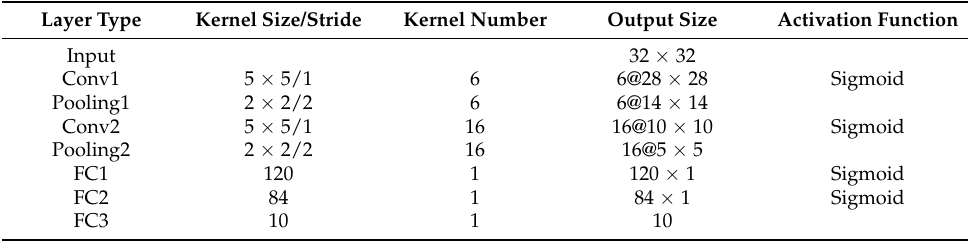
Table 1. Detailed settings of LeNet-5